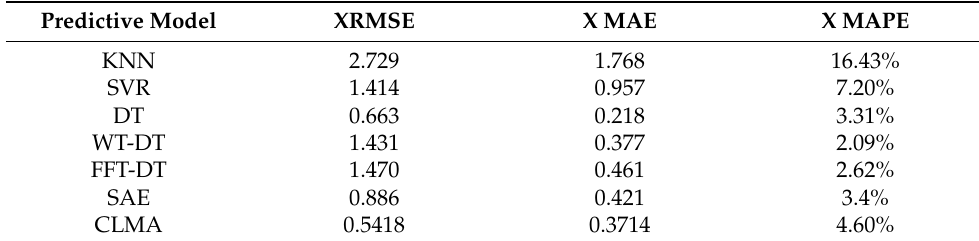
Table 2. Fault location performance of different models.